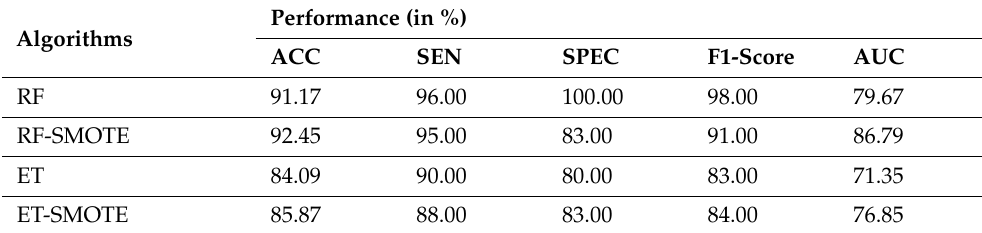
Table 4. Performance of existing ensemble AI systems using hold-out